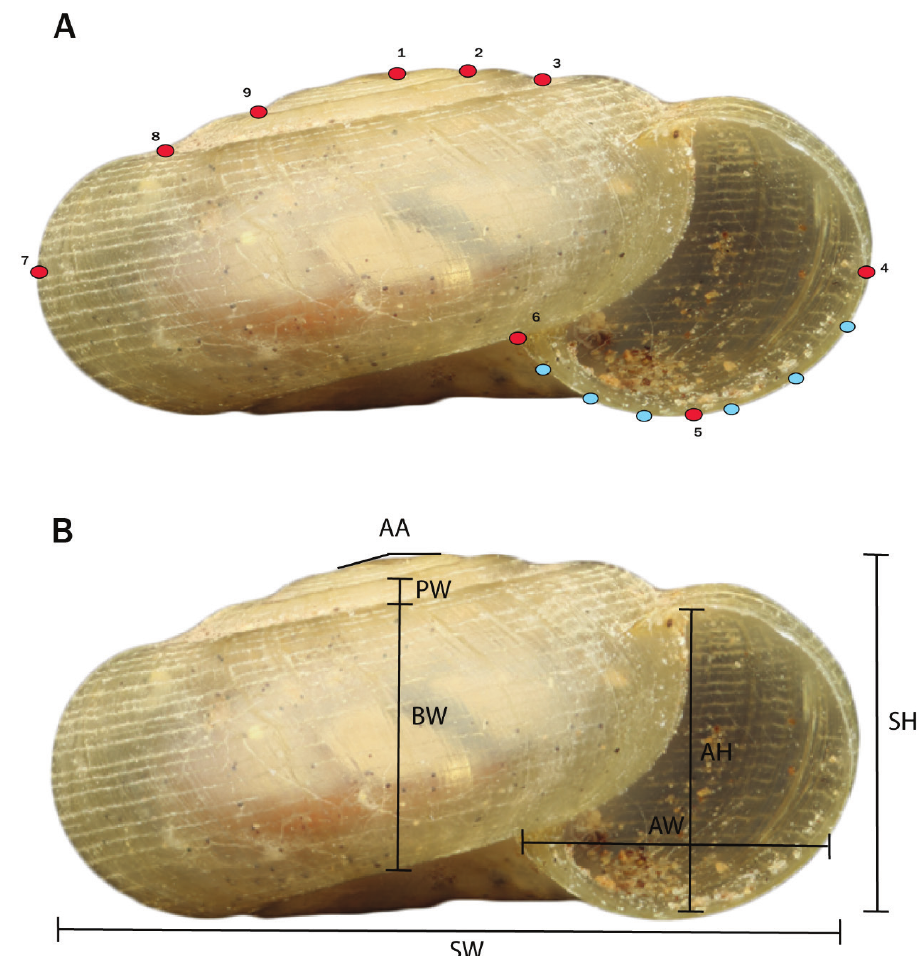
Figure 2. A Landmark scheme for geomorphometric analyses. Red circles represented landmarks (LM), blue circles represent semi-landmarks (SLM). B Shell measurements utilized for the traditional morpho- metric (TM)